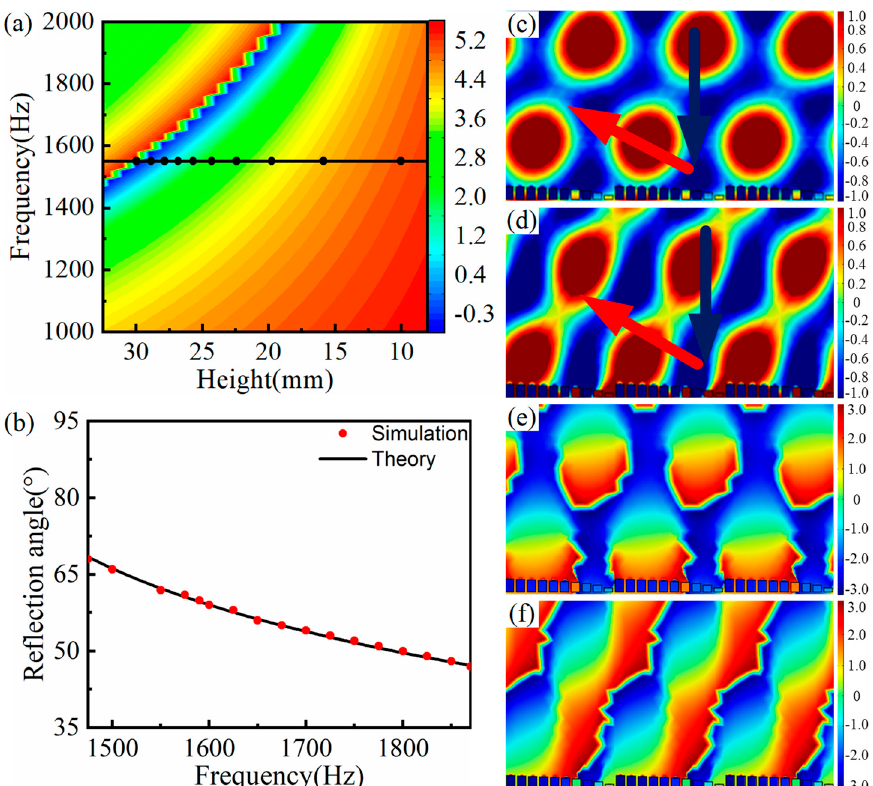
Figure 7. AMS of ten SHCs with different heights at the phase gradient of π /125 rad/mm. ( a ) The reflection phase modulation map, where the corresponding frequency of the black curve is the designed center frequency and the corresponding height of the black circle symbols is chosen as the height of ten SHCs; ( b ) the AMS relationship curve between frequency and the anomalous reflection angle; ( c ) and ( d ) reflected acoustic pressure field distribution at 1550 Hz and 1590 Hz; and ( e ) and ( f ) reflected phase distribution of corresponding (c) and (d), respectively.